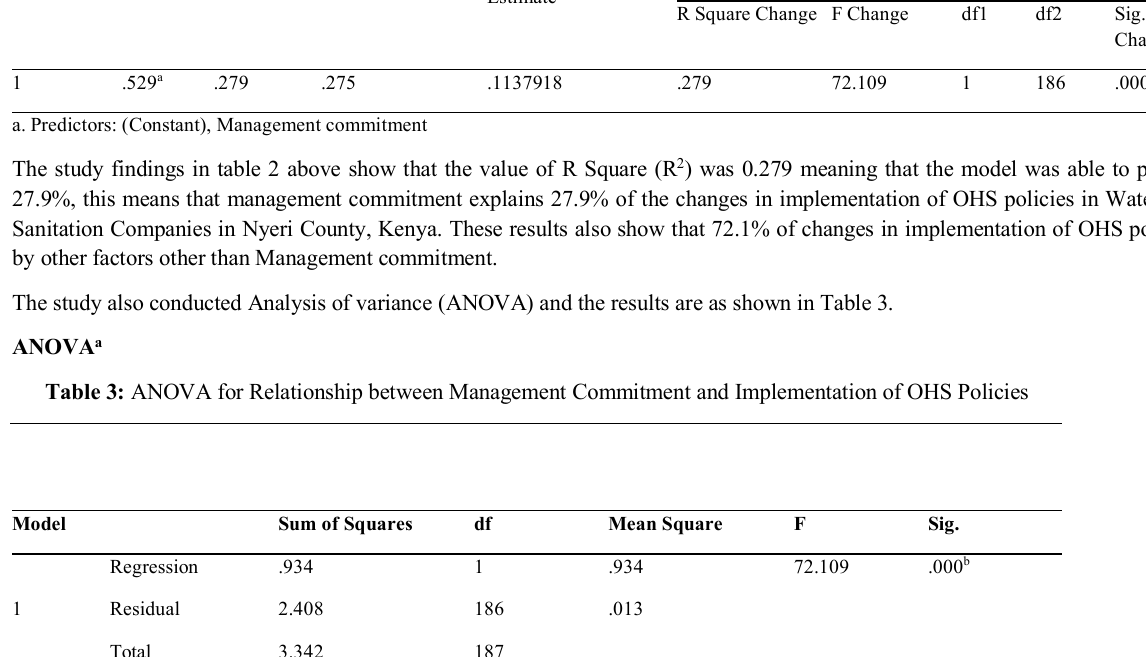
Table 2: Model Summary for Relationship between Management Commitment and Implementation of OHS Policies Model